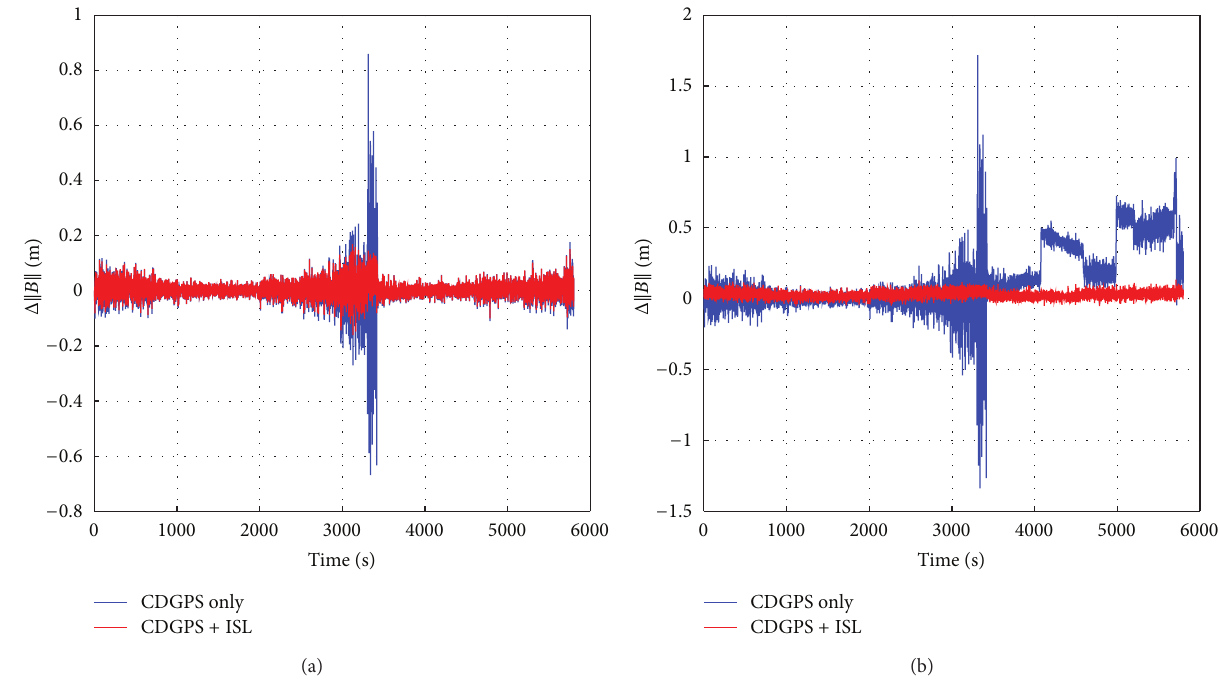
Figure 5: (a) Baseline norm error (the first case). (b) Baseline norm error (the second case).